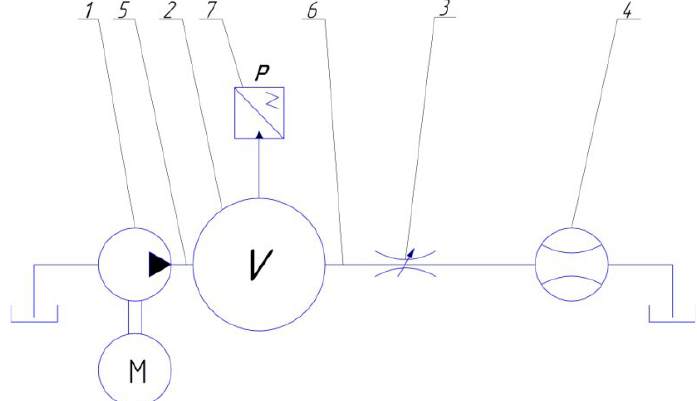
Figure 17. ISO 1219 scheme of the bench system implementing the capacitive load impedance at the liquid output from the pump: 1—pump; 2—cavity volume; 3—load throttle; 4—flow sensor; 5 and 6—connecting fittings and 7—pressure sensor.